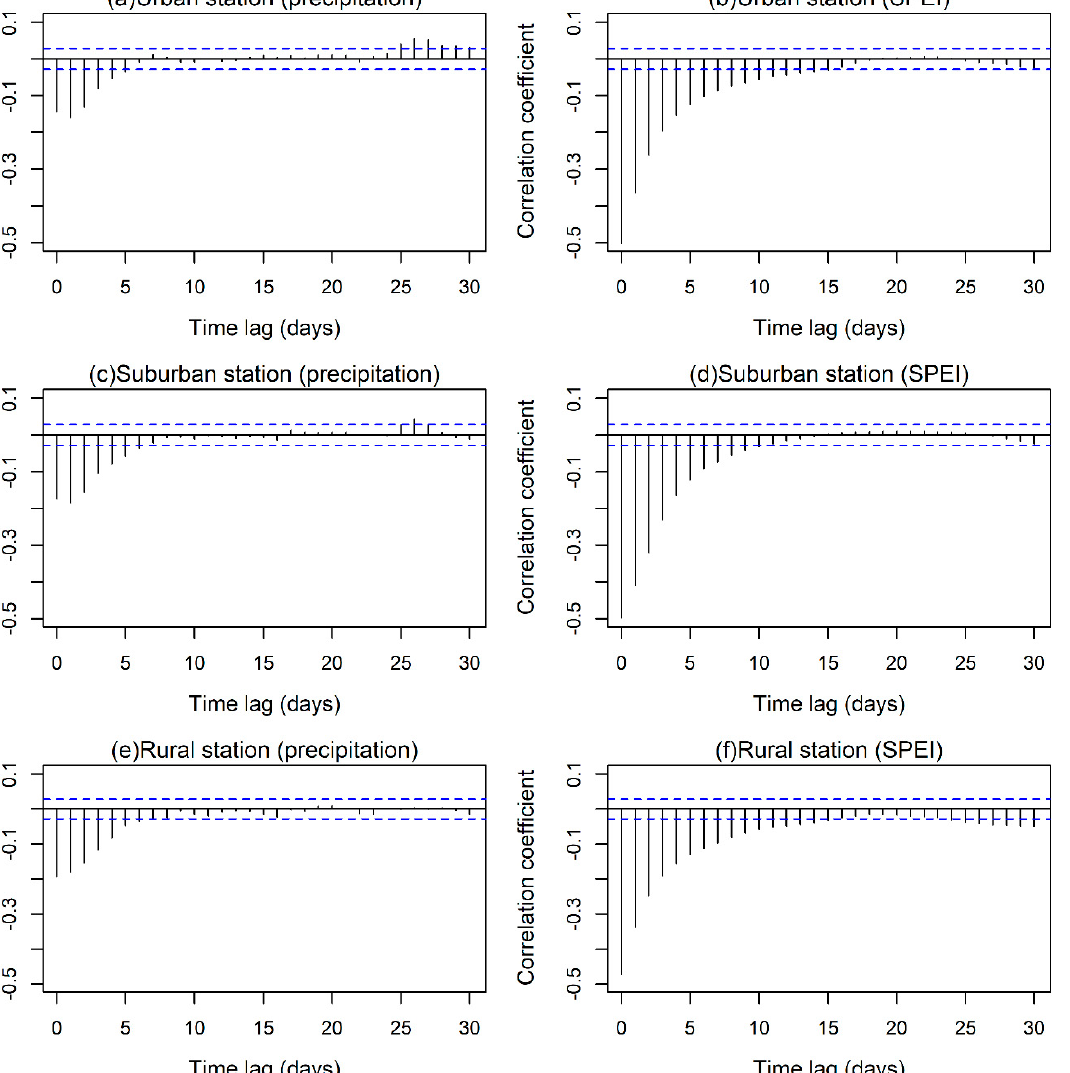
Figure 5. Cross correlation (y) for daily maximum temperature anomalies and precipitation (left column) or SPEI (right column) in the urban station, the suburban station, and the rural station. Dotted blue horizontal lines show 95% significance